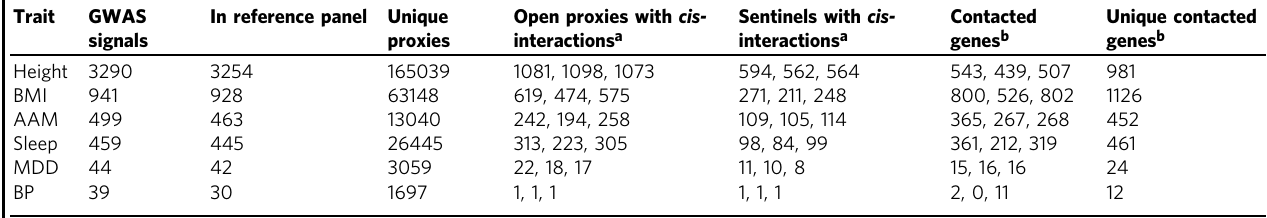
Table 1 Summary of variant-to-gene mapping results of GWAS signals for each trait. Trait GWAS